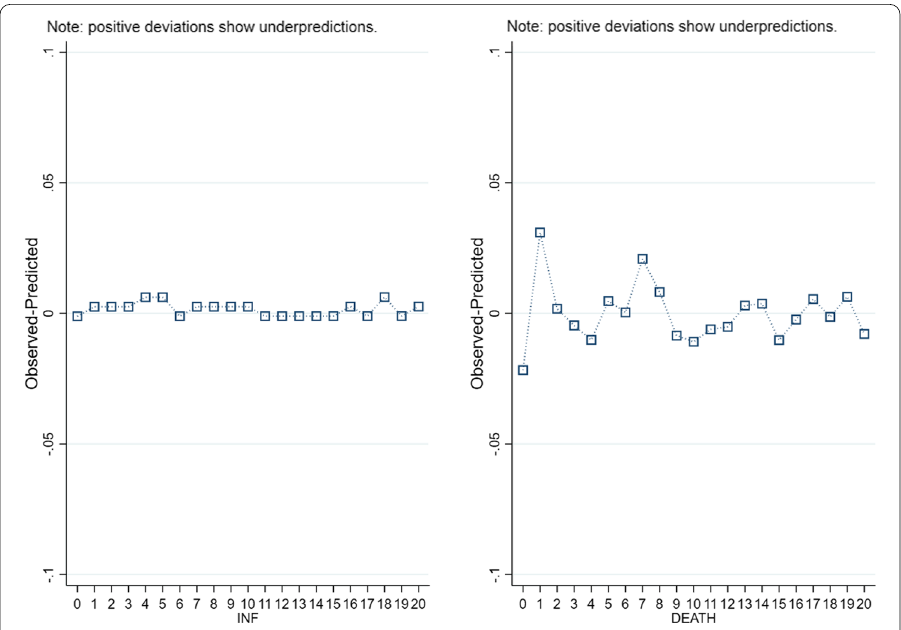
Fig. 7 Difference between observed and predicted INF (left) and DEATH